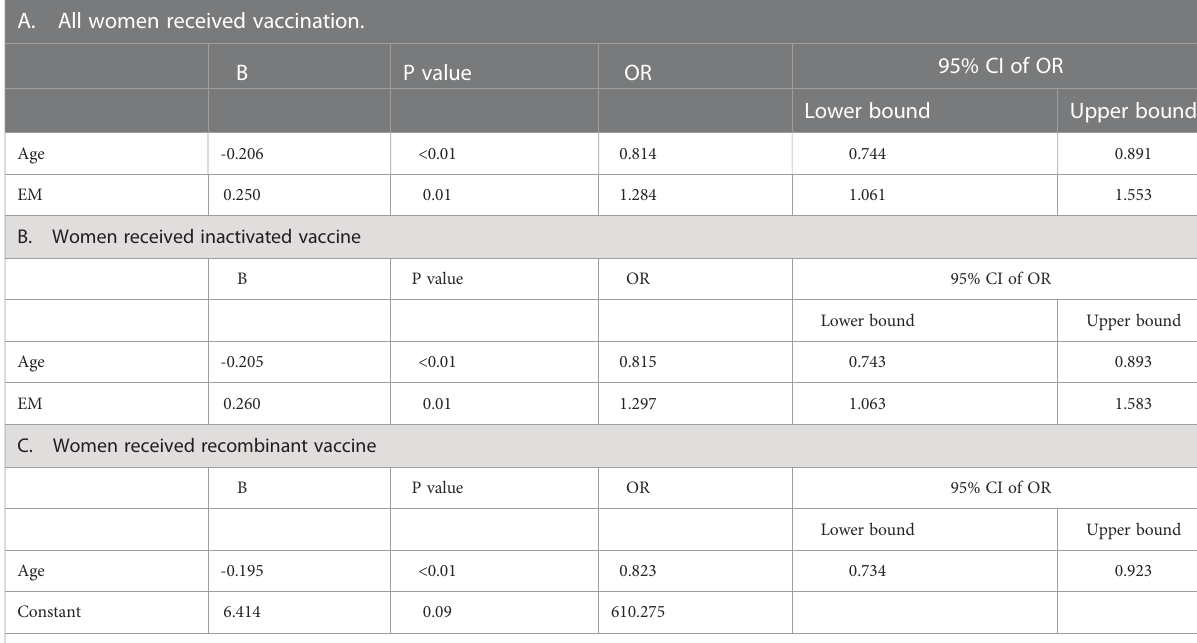
TABLE 5 Multivariate regression analysis on clinical pregnancy rate (only women received embryo transfer). A. All women received vaccination.